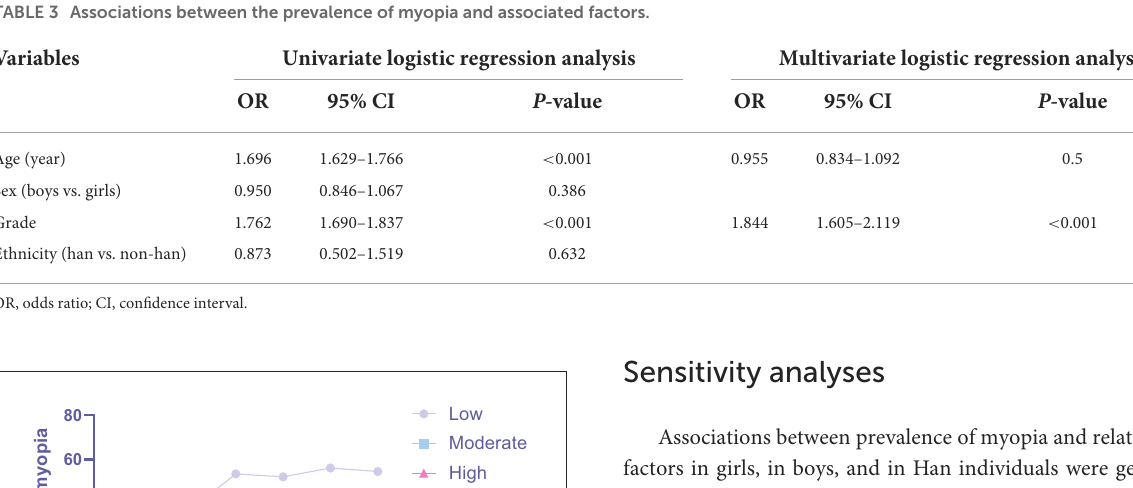
TABLE 3 Associations between the prevalence of myopia and associated factors.